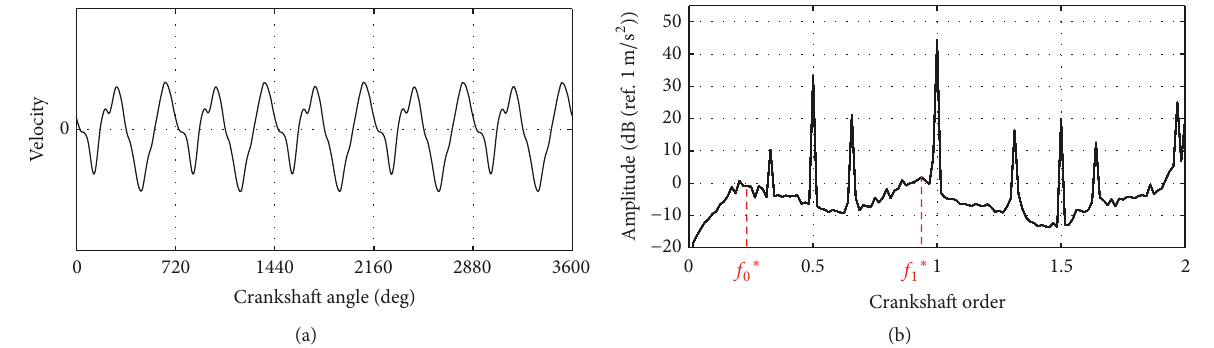
Figure 10: Crankshaft-angle-based trend and order-based spectral analysis of 𝑛 rel for Regime A of the 70 Sh tests.